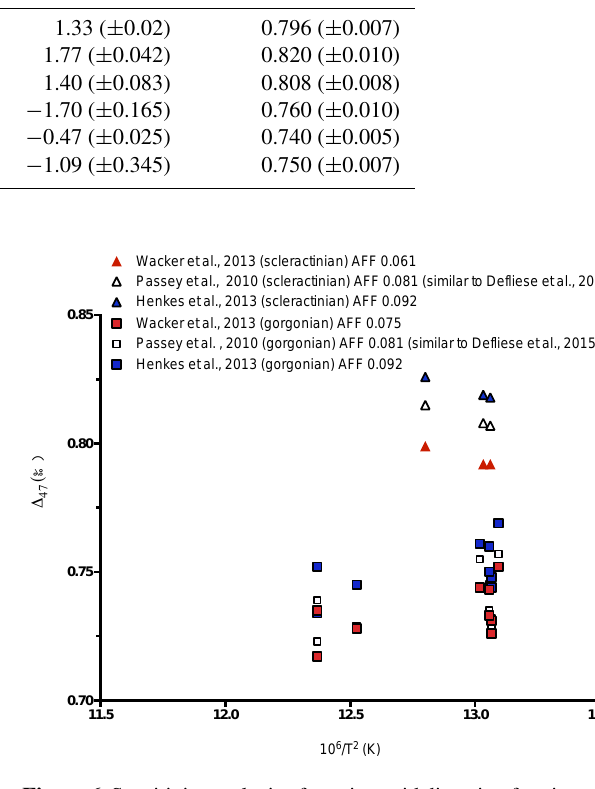
Figure 6. Sensitivity analysis of varying acid digestion fractionation factor ( (cid:49) 25 − 90 ) on